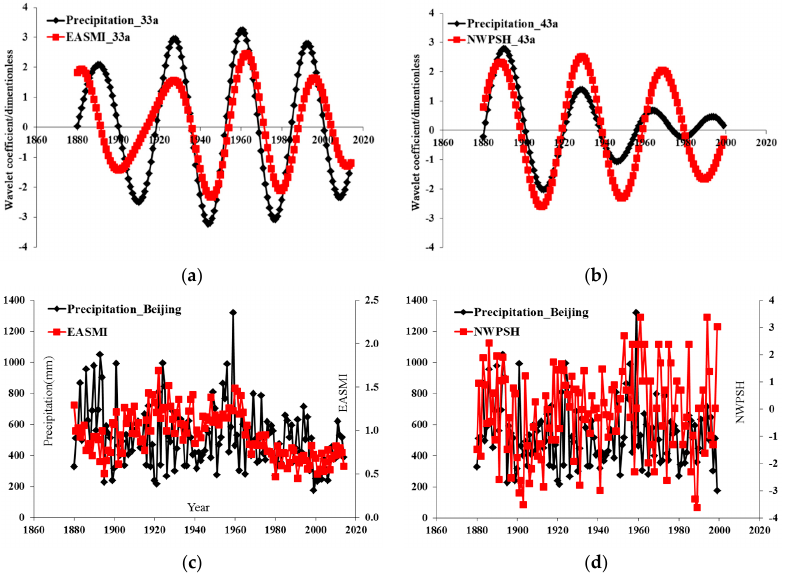
Figure 5. Related periodic components and variations of Beijing summer precipitation and the EASMI ( a , c )/NPWSH ( b , d ). In addition to EASM and WPSH, the pacific decadal oscillation (PDO) and El Niño-Southern Oscillation (ENSO) also affect the climate of China. These were considered to be closely related to